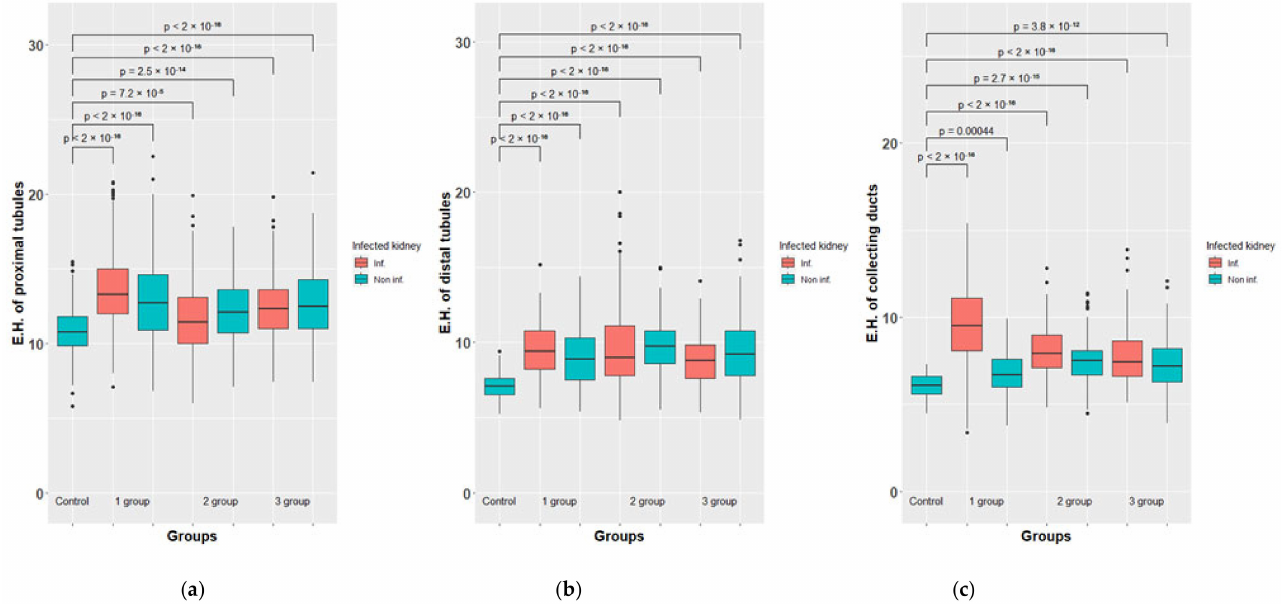
Figure 8. Morphometric results of the rabbit’s kidney of groups 1-3 vs. control. The height of epitheliocytes (E.H.) of proximal tubules, µ m. ( a ). The height of epitheliocytes (E.H.) µ m. of distal tubules ( b ) and collecting ducts ( c